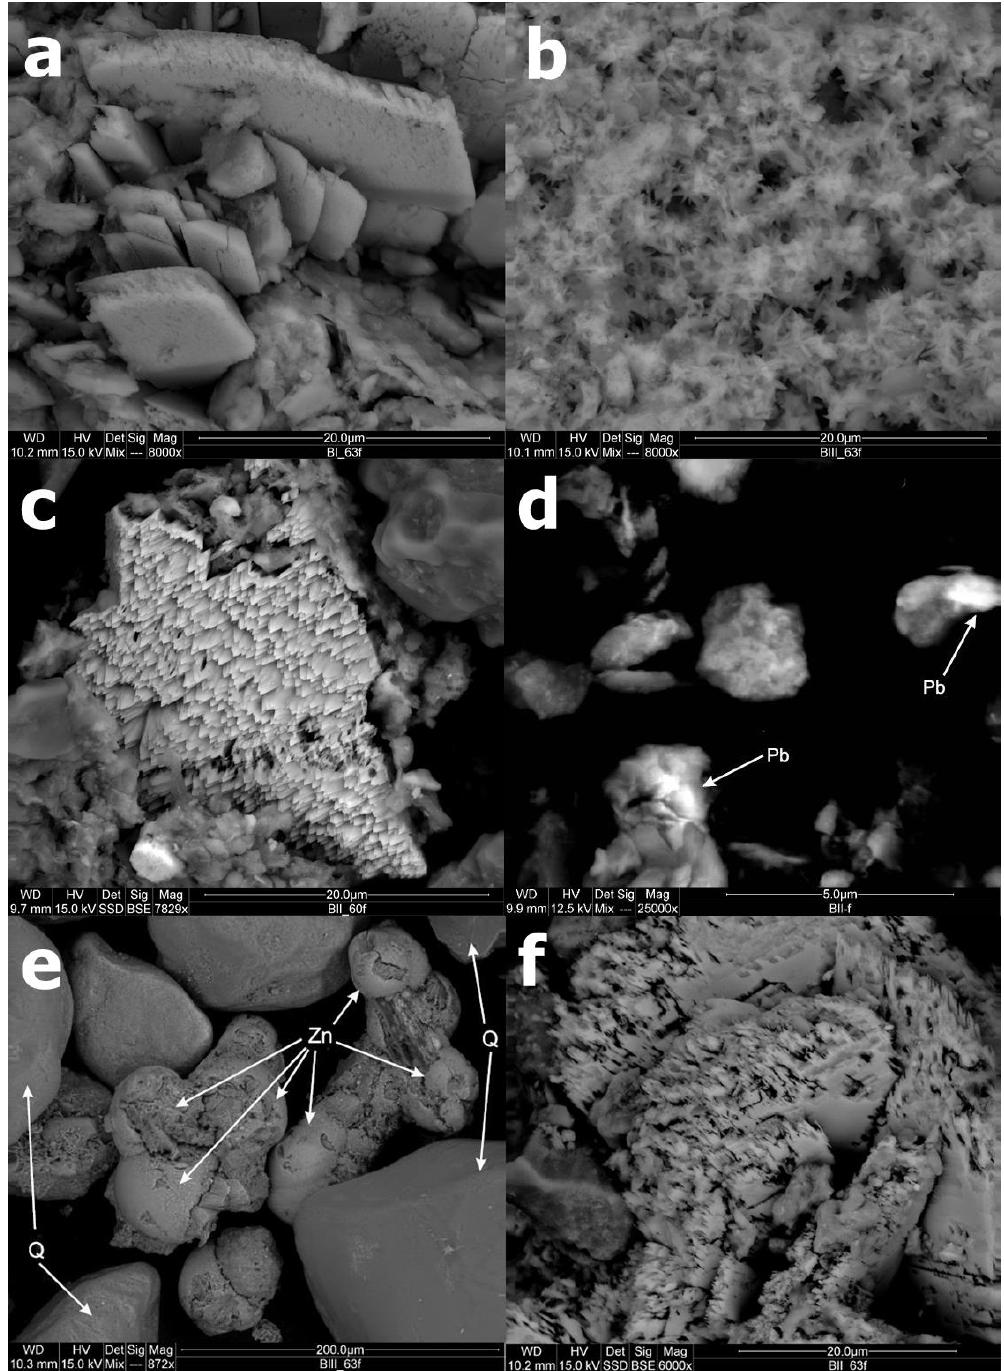
Figure 6. SEM images: ( a ) lamellar forms of zinc phosphate (BI-ES), ( b ) needle forms of lead phosphate (BII-ES), ( c ) brush made of parallel conical crystals—zinc silicates (BII-ES), ( d ) lead phosphate structures (BII-ES), ( e ) spherical forms of zinc phosphate on carbonates (BIII-ES), ( f ) lamellar forms of zinc phosphate (BII-ES).